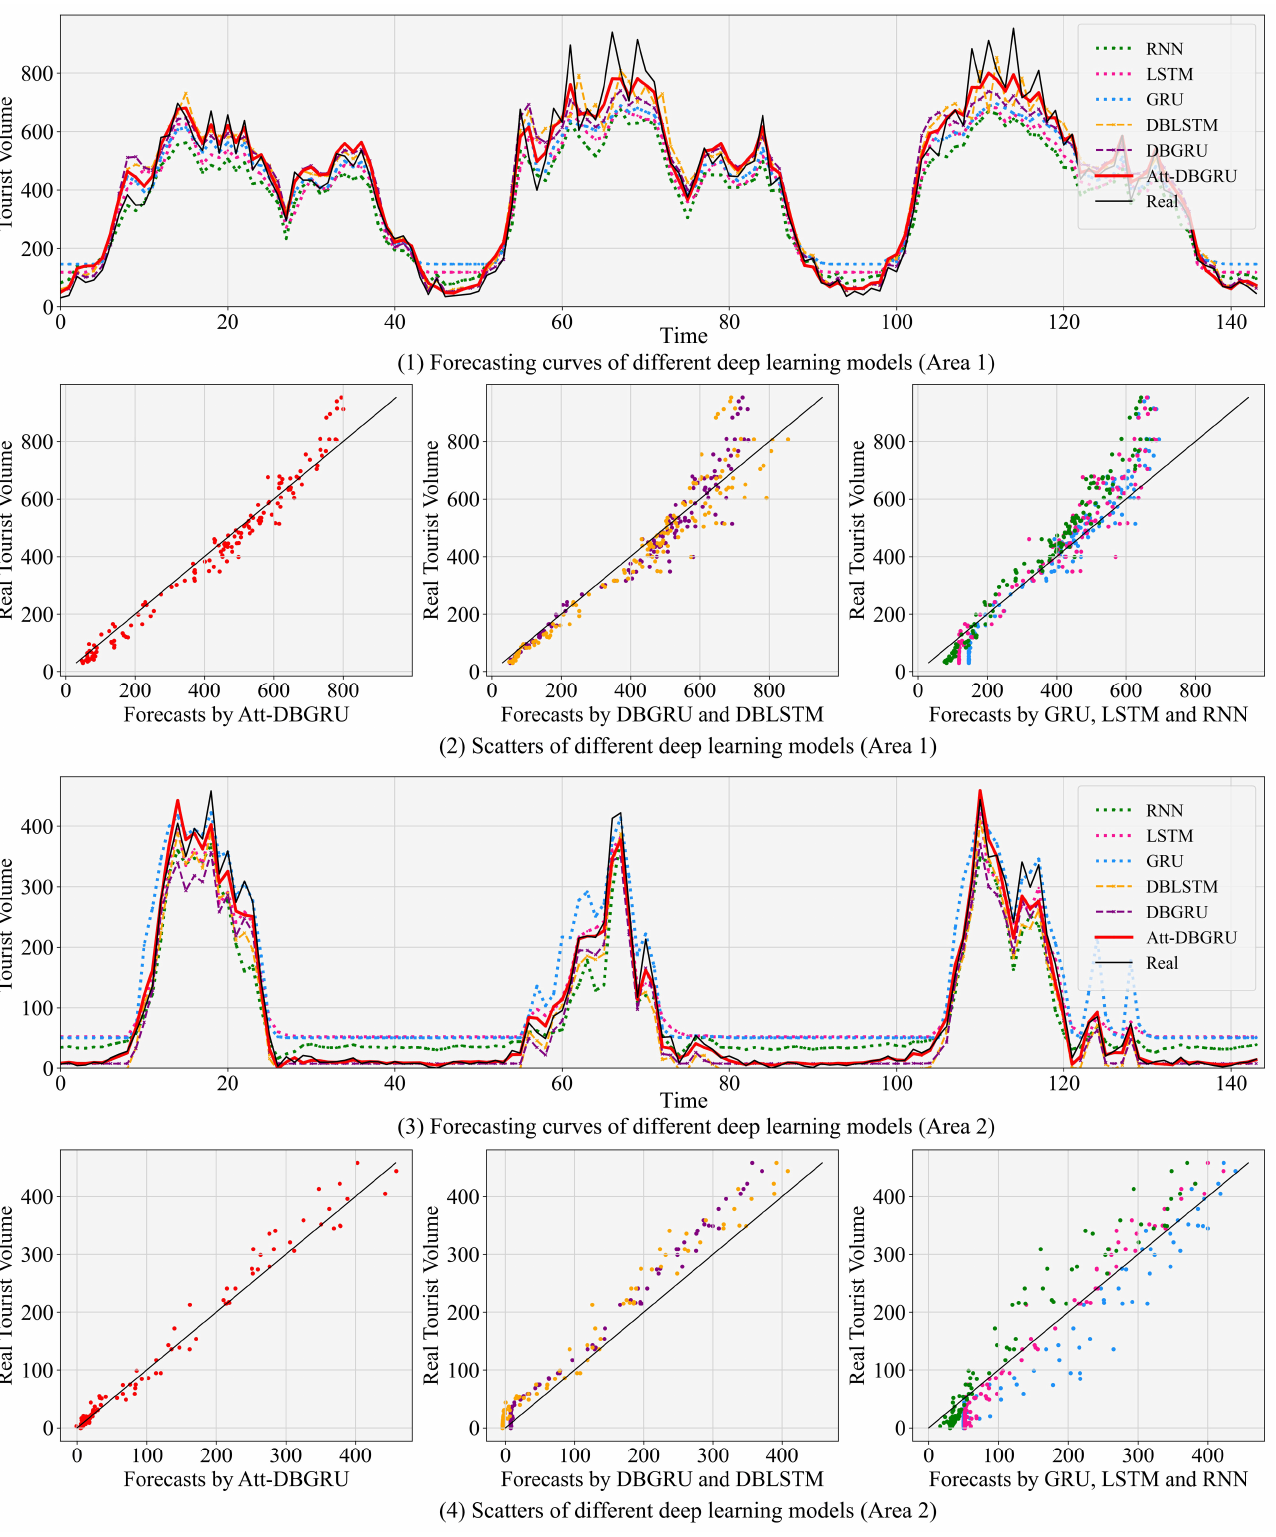
Figure 6. Real and forecasted tourist volumes of the two sub areas (Area 1 and Area 2).